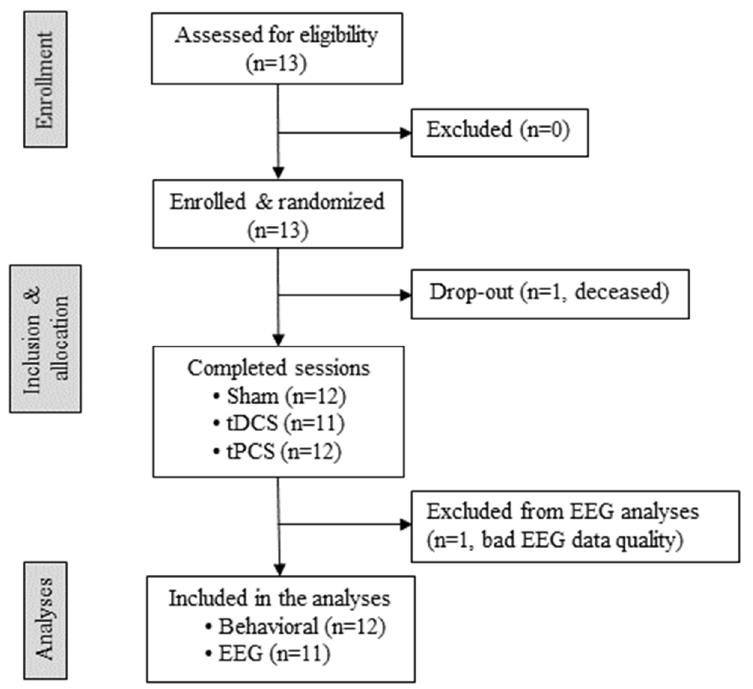
Figure 2. Flow chart of patient enrollment. The specifics on patients’ enrollment, allocation, and analysis are reported. We were in contact with the collaborating centers, and when a patient matched the inclusion criteria, we were contacted by their health care team to go screen the patient and confirm eligibility. This is why this could be considered as a convenience sample (i.e., non-probability sampling, typical of pilot studies). Thirteen patients were screened for eligibility. All patients were randomly allocated to a specific order of the three sessions (see Table 1 for details). One patient died after the randomization for medical reasons external to the study. Eleven patients received all three sessions, one patient received tPCS and sham, but no tDCS due to decompressive craniectomy that took place after the first two sessions. One patient was not included in the EEG analysis due to the poor quality of the EEG data. Transcranial direct current stimulation (tDCS), transcranial pulsed current stimulation (tPCS), electroencephalography